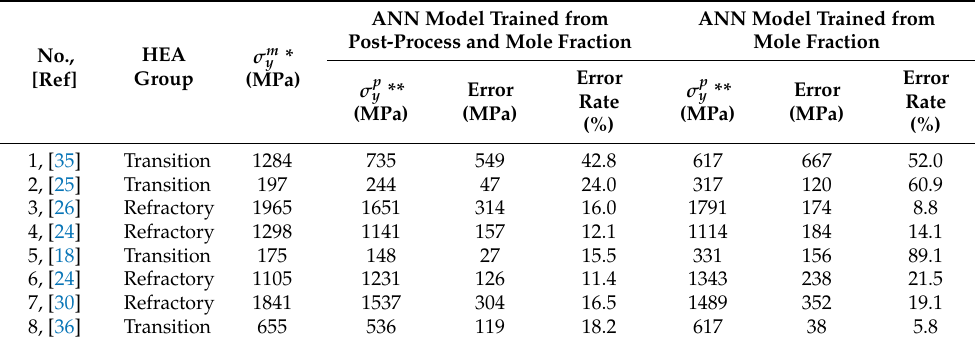
Figure 3. Accuracy of an ANN model trained only on elemental mole fractions. Table 4. Comparison of the predicted results data calculated by the ANN model, which was trained on post-process and mole fraction data vs. mole fraction data.